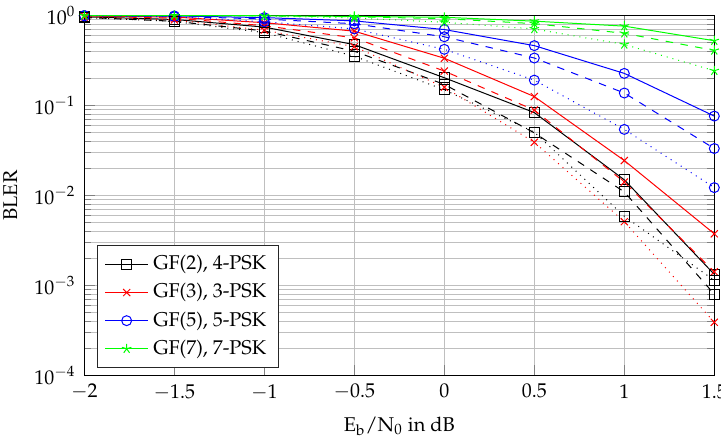
Figure 8. Block error rate for polar codes on GF(q) for list size L = 32 (solid line), L = 100 (dashed line) and L = 625 (dotted